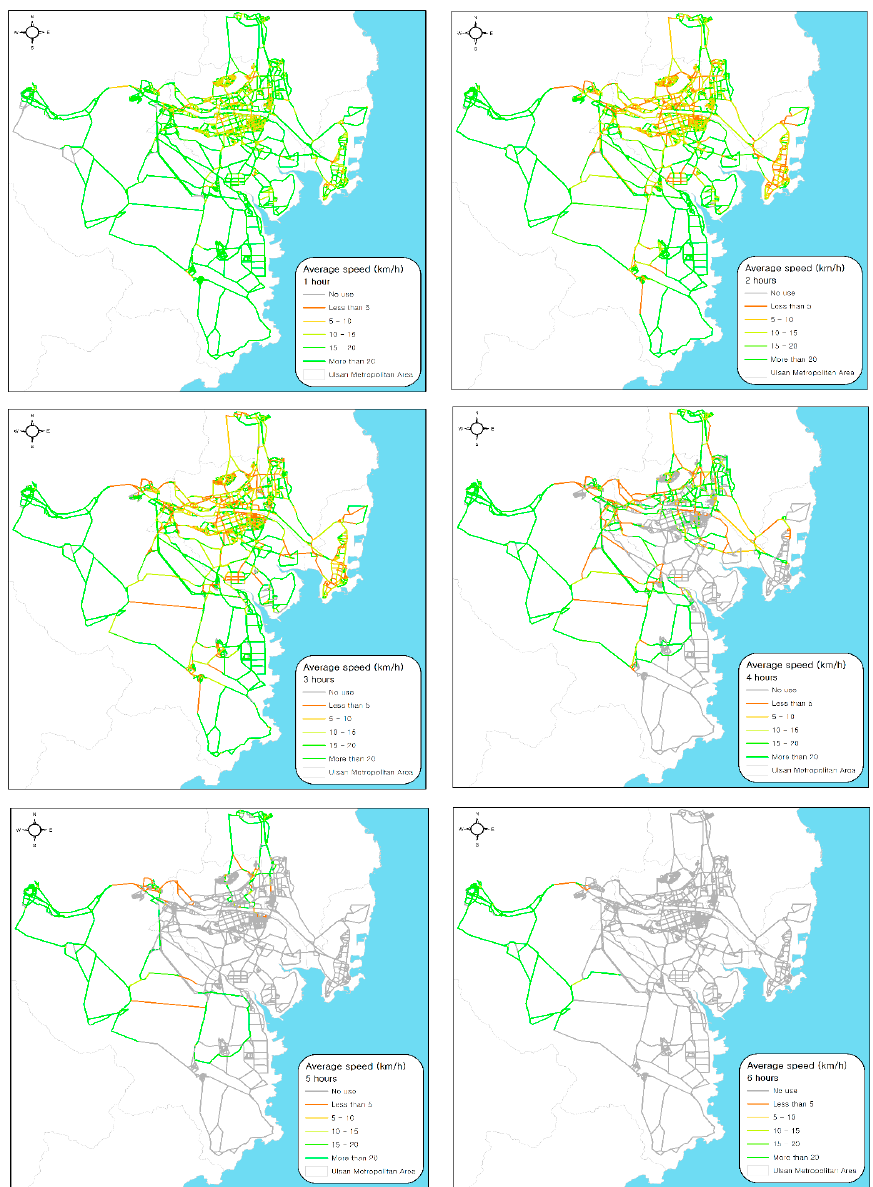
Figure 6. Average speed of vehicles from 1 to 6 h after the occurrence of accidents.